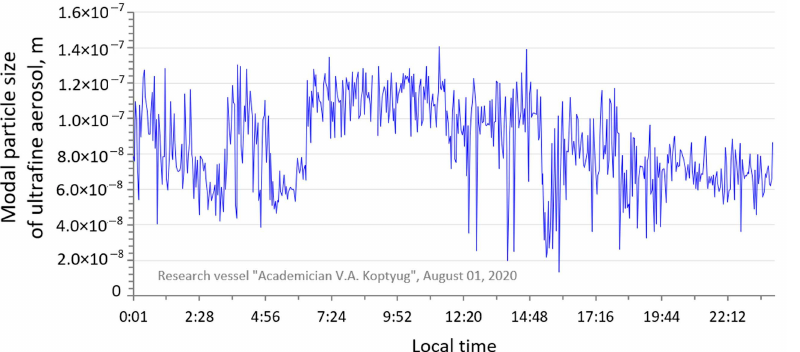
Figure 6. Daily course of modal particle size of ultrafine aerosol in Maloye More area, 1 August 2020.